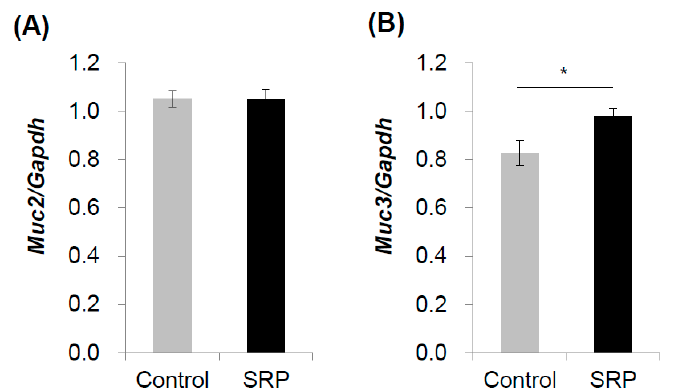
Figure 2. Quantification of Muc2 and Muc3 gene expression in the lower ileum. Relative gene expression of ( A ) Muc2 and ( B ) Muc3 were investigated in the lower ileum of mice fed a control diet (control) and a diet with sake cake and rice malt (SRP) for four weeks by a qRT-PCR method. The expression ratios of target genes to Gapdh were calculated. Data are shown as the mean ± SEM ( n = 7). * p < 0.05.